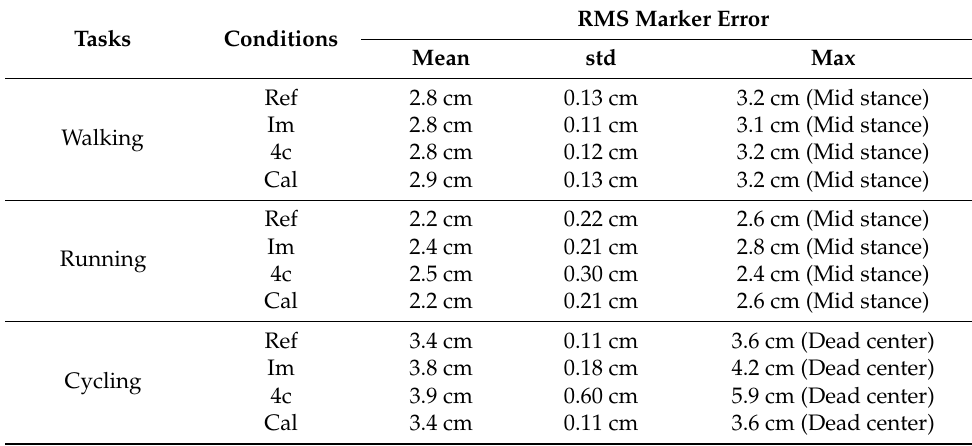
Table 2. Descriptive statistics on the inverse kinematics step performed by OpenSim with a full body model adapted from Rajagopal’s [69]. Root mean square (RMS) errors between experimental and model markers were calculated over all markers. Mean, standard deviation (std), and maximum (max) are displayed. Dead center refers to the phase where the crank is near the vertical